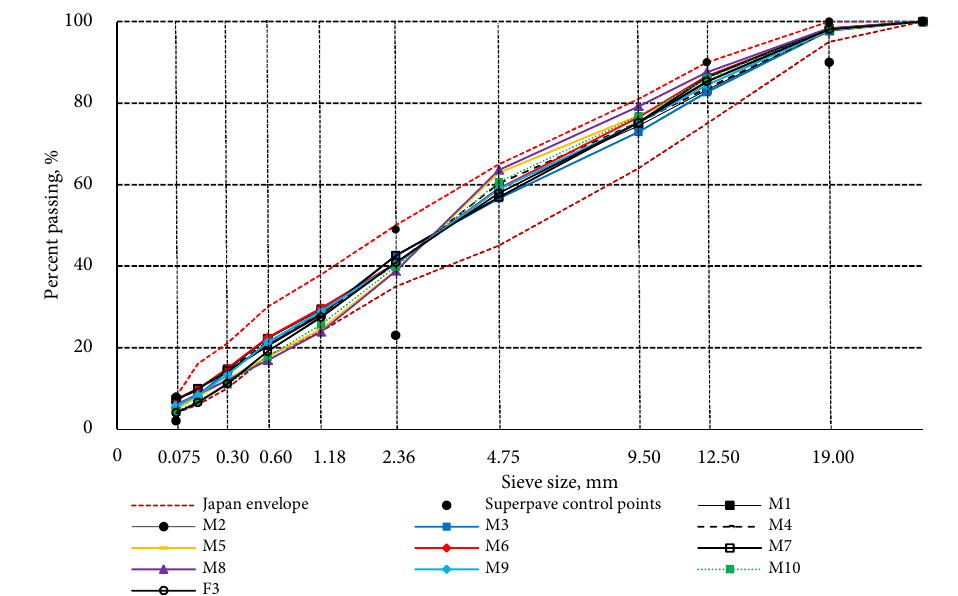
Fig. 2. The gradation curves of the mixtures in this study Table 4. The size distributions of the blends, their Bailey ratios and the estimated values of